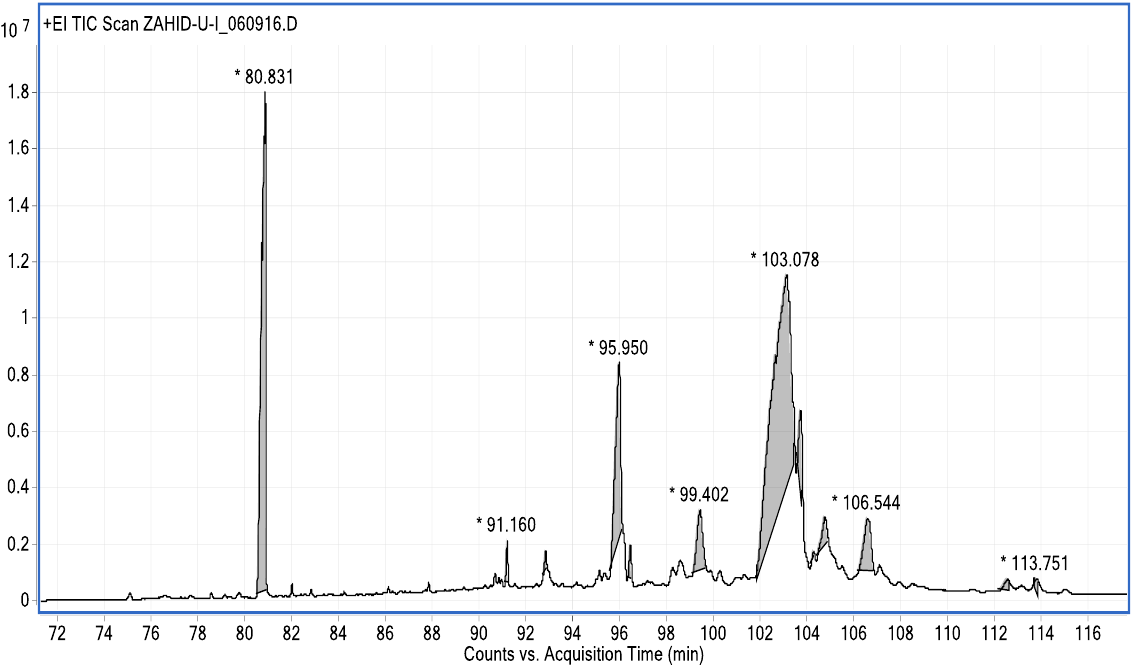
Figure 2. GC–MS chromatogram showing peaks in the range of 72–116, * denoted high values. The mass spectrum of the identified compounds is presented in Figures 3–5.